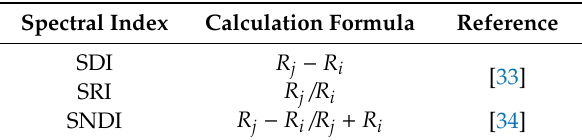
Table 2. Constructed spectral